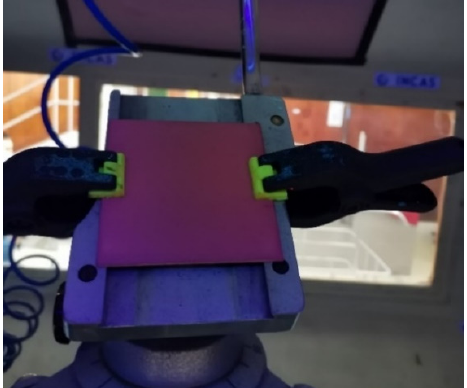
Figure 4. Test specimen mounted in the holder and exposed to UV light.